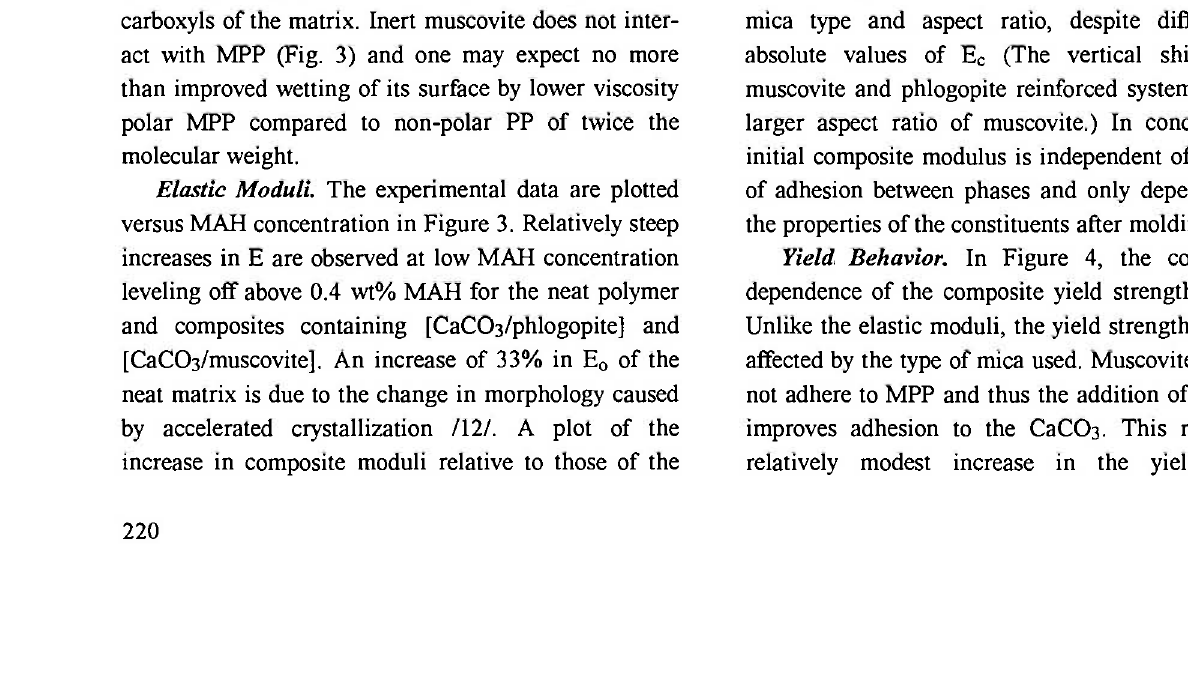
Fig. 1(b): SEM micrograph of fracture surface of PP/[CaC03/muscovite] composite with a weak matrix-filler adhesion. Initial flake size was 280 μηι; however, substantia] mechanical degradation occurred during melt mixing. An average flake size of 50 μηι was estimated after mixing. Surface was prepared by fracturing a 4x6x50 mm 3 specimen containing sharp notch in impact. CaCCtymica ratio was 1/3. Magnification 600